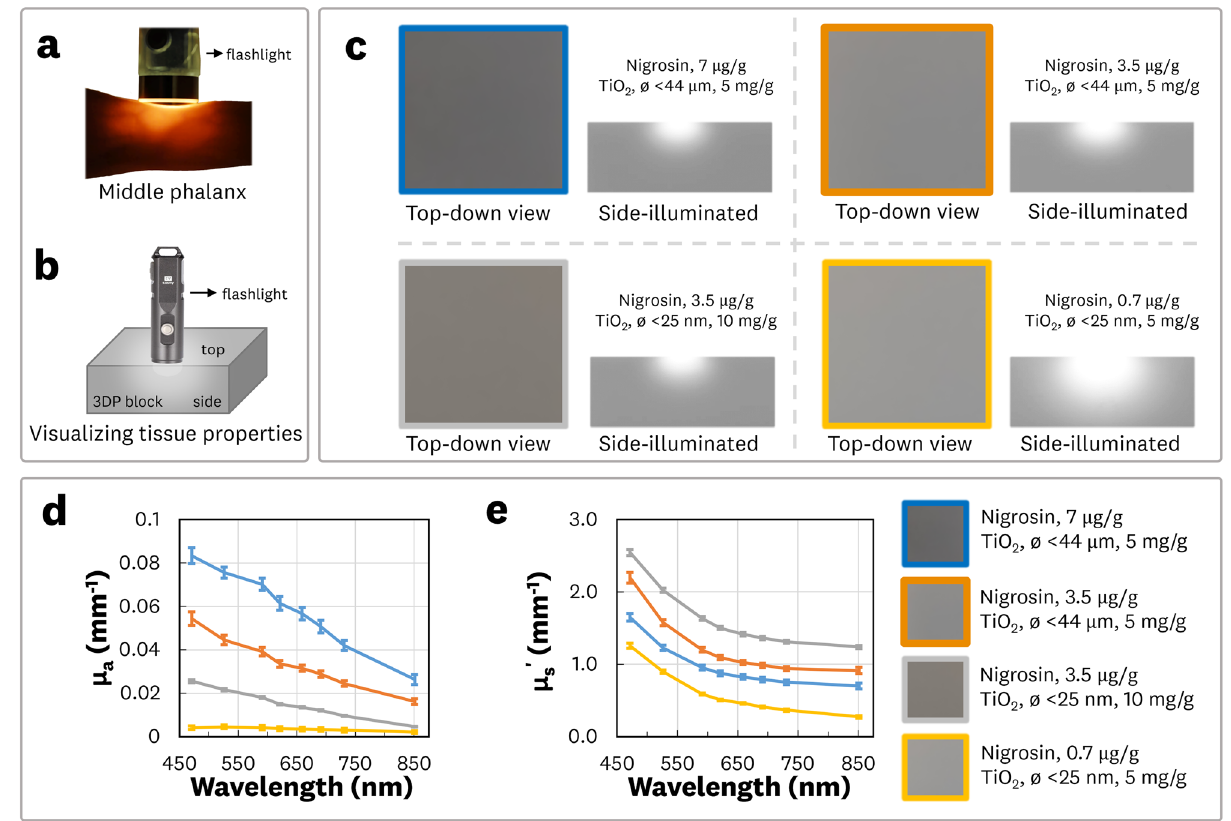
Figure 5. Visualization and measurement of absorption and reduced scattering properties. ( a ) Image of a side-illuminated middle phalanx. ( b ) Side-illuminated method for visualization of optical properties of 3DP 50 × 50 × 20 mm 3 blocks. ( c ) Top-down and side-illuminated images of four 3DP blocks with varying nigrosin and TiO 2 concentrations. Measured absorption ( d ) and reduced scatter ( e ) coefficients spectra for the four 3DP blocks. Error bars indicate ± one standard deviation from the